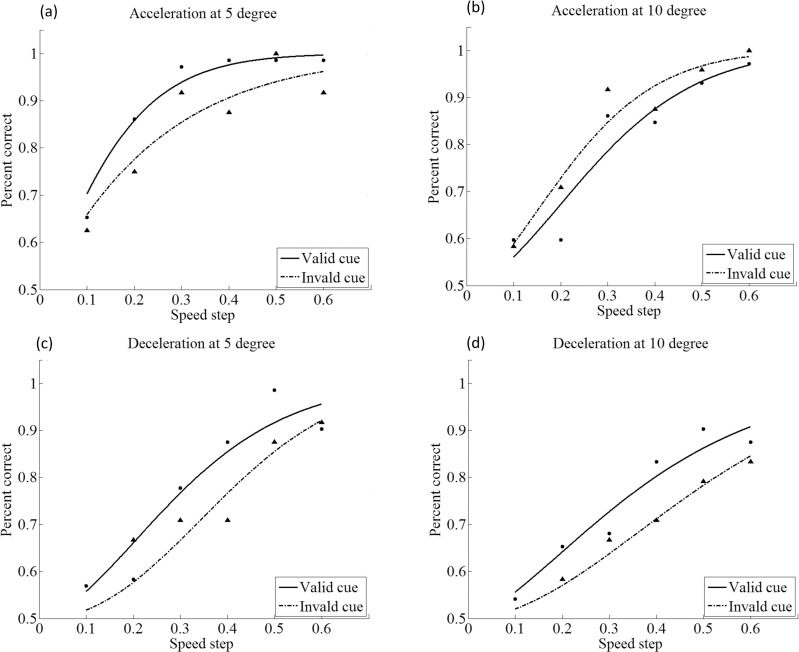
Effects of endogenous attention on the psychometric functions for speed-change detection in Exp 2.Solid lines are curve fittings for the valid-cue condition, dashed lines for the invalid-cue condition. Acceleration is shown on top panels a and b, and deceleration on bottom panels c and d.